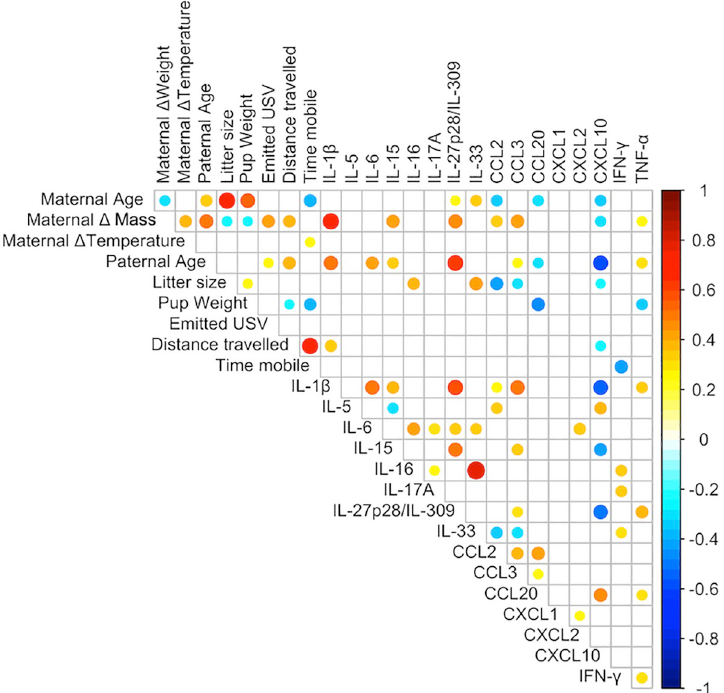
Fig 2. Correlation between numerical variables. Heatmap of pairwise Spearman’s rank r correlation coefficients between variable pairs. Spearman’s r coefficients are color-coded and proportional to dot area. Only significant correlations are shown (p <